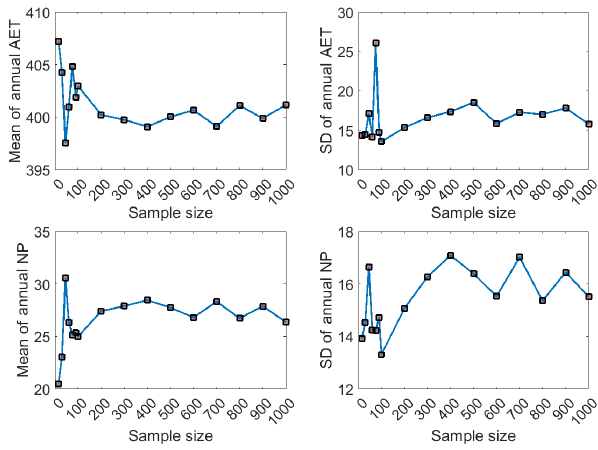
Figure A4. Mean and SD values of the annual AET and NP corre- sponding to each sample size for the MC sampling method.